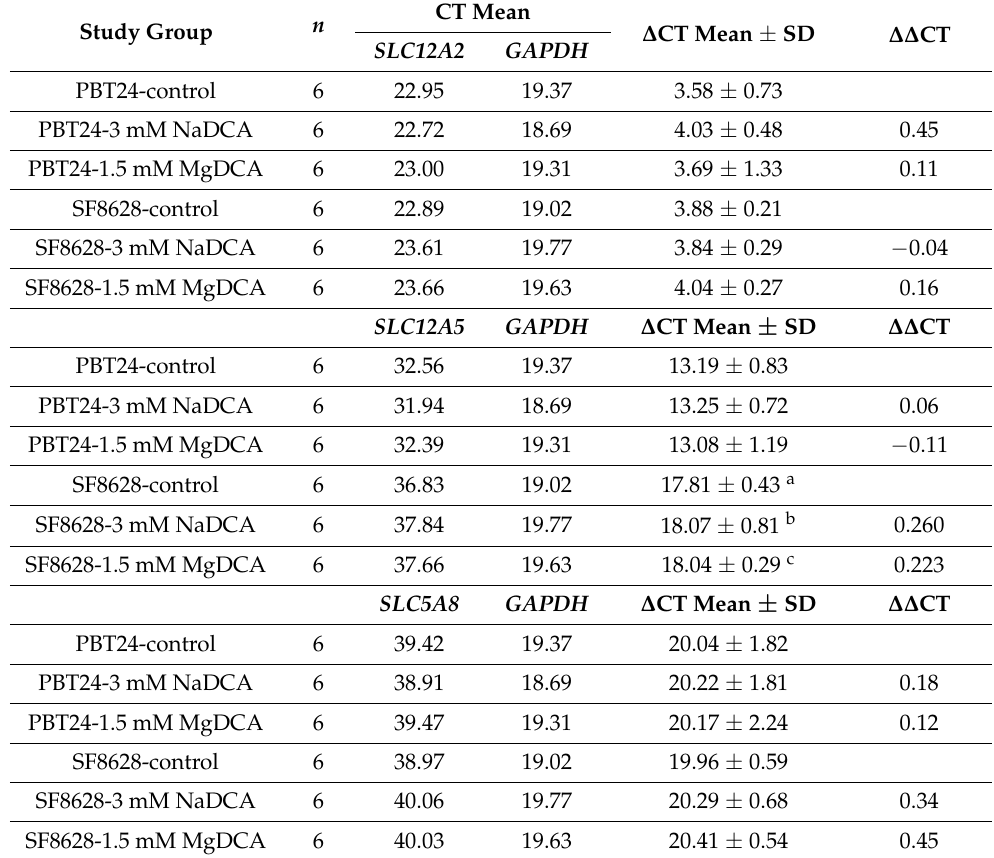
Table 6. The expression of SLC12A2 , SLC12A5 , SLC5A8 , and GAPDH genes in tested PBT24 and SF8628